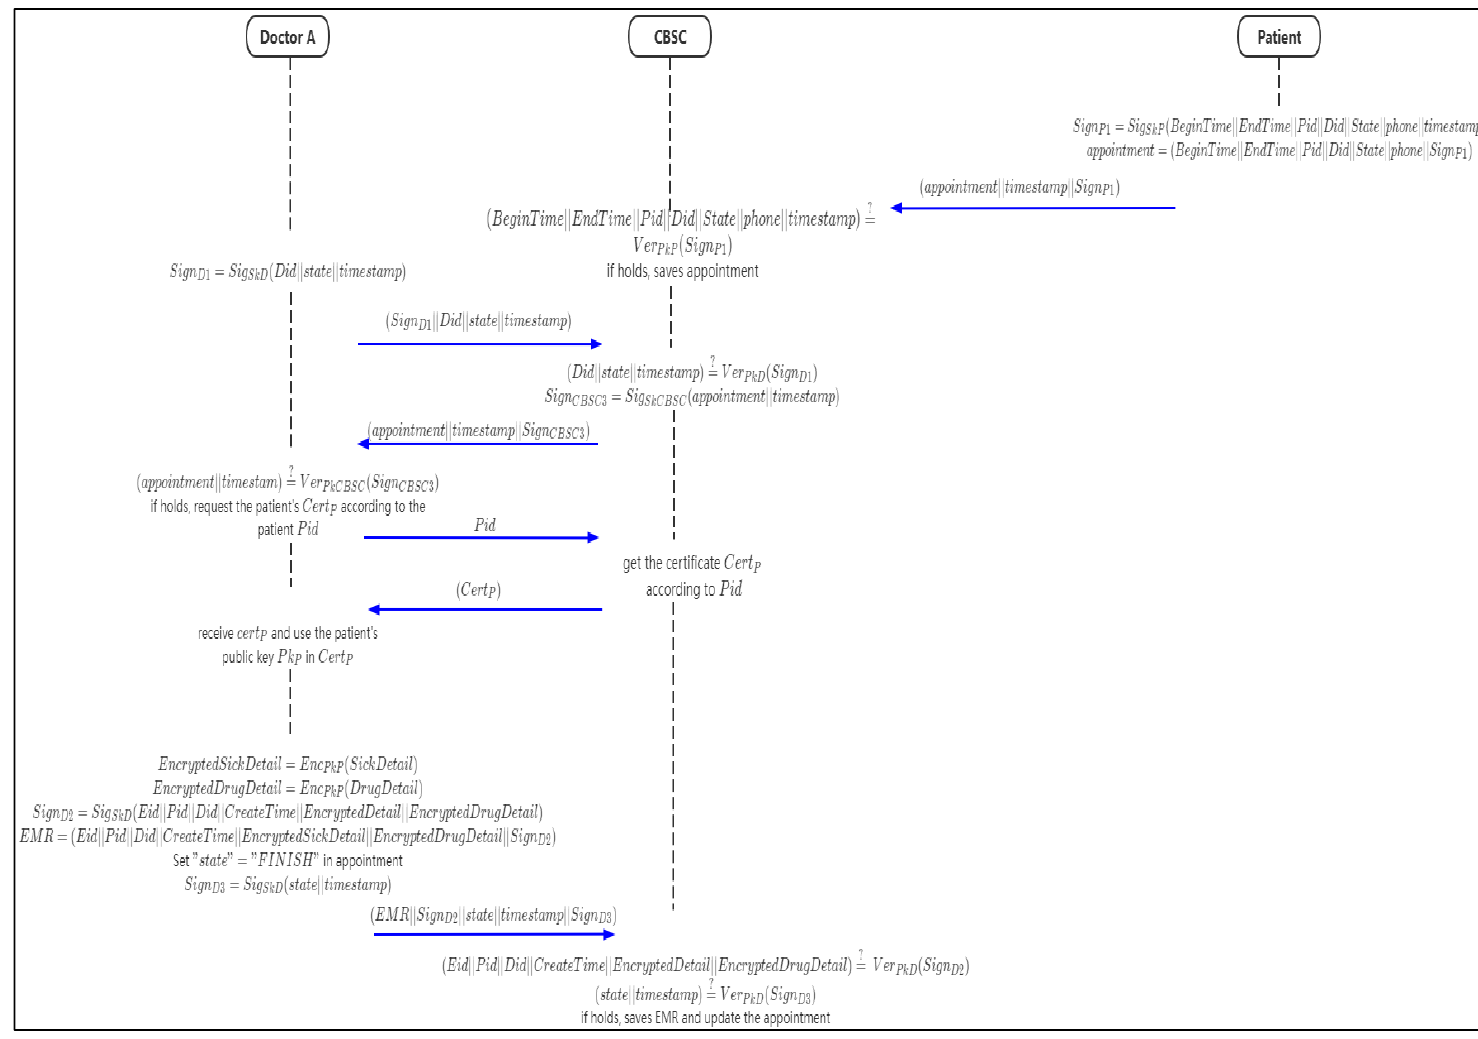
Figure 8. The flow chart of appointment and EMR generation.